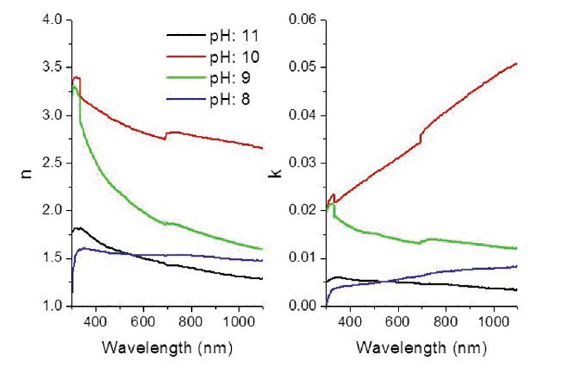
Figure 6. Plot of the refraction index and extinction coefficient of MnSeO